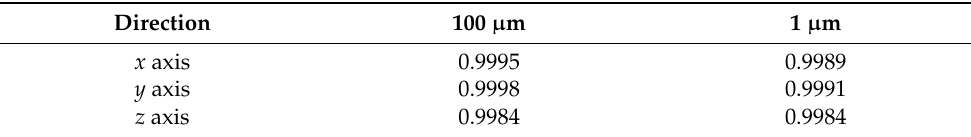
Figure 5. ( a ) Measurement results for 100 μ m periodic displacements and ( b ) Measurement results for 1 μ m periodic displacements. Table 1. R-squared values of medium- and short-range triangular displacement signals on the x -, y -, and z -axis.